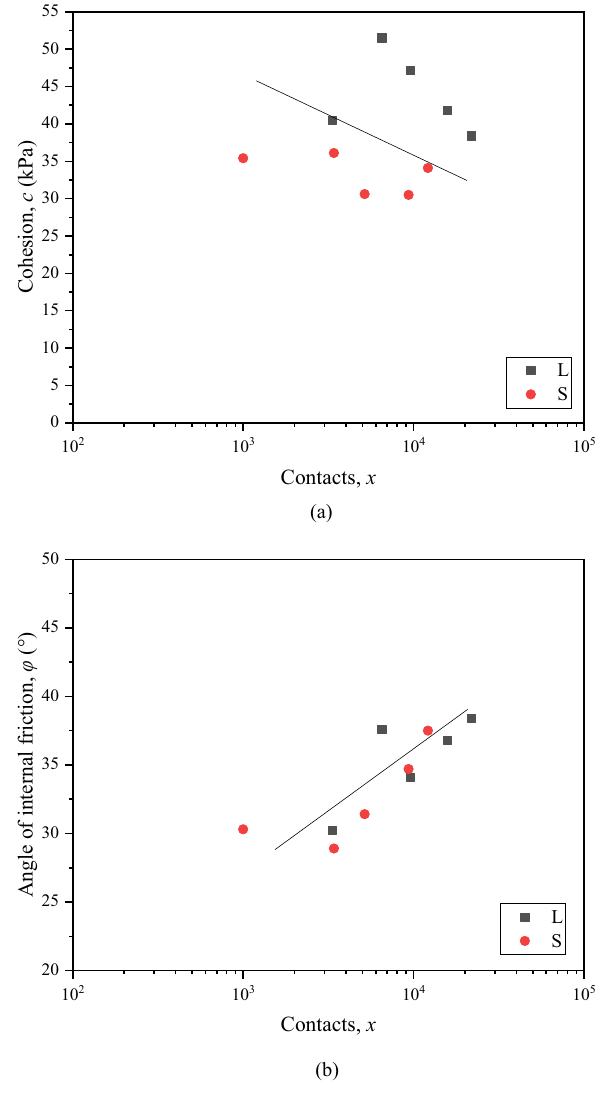
Figure 9. Relationship between ( a ) the cohesion, ( b ) internal friction angle and contacts of calcareous